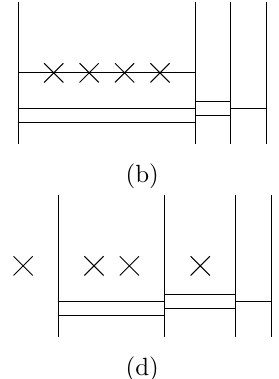
Figure 8. Example of a Kraft-Procesi transition. (a) Coulomb branch brane con(cid:12)guration with M C = (cid:22) O . (b) The relevant D3-brane is in the singular point ~x = ~m i = (0 ; 0 ; 0). (c) The (4)